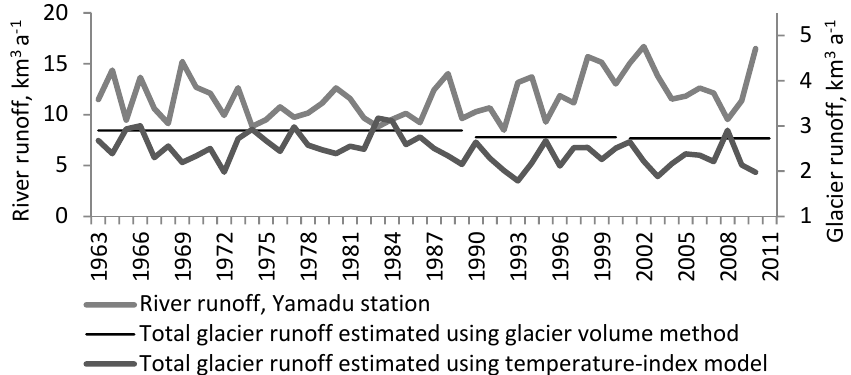
Figure 13. Change in the measured annual runoff of the Ile at the Yamadu station, total glacier runoff and runoff due to the melt of multiyear ice.